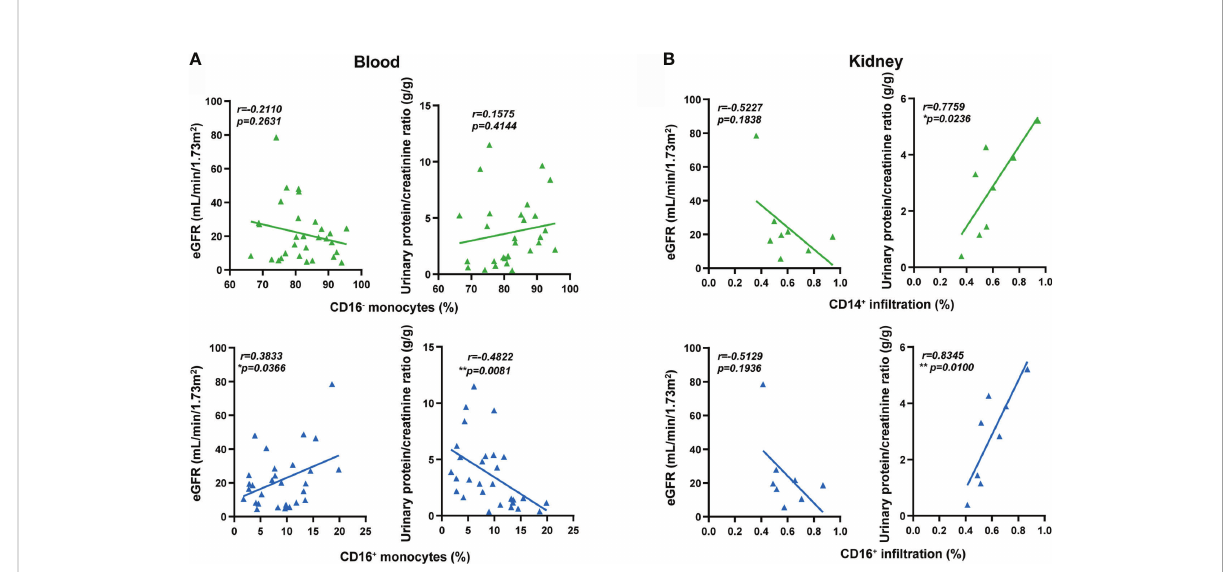
FIGURE 5 Extravasation of CD16 + monocytes was associated with renal damage in MPO-AAV patients. (A) The percentage of monocyte subsets (CD16 + and CD16 - monocytes) correlated with estimated glomerular fi ltration rate (eGFR, mL/min/1.73m 2 ) and urinary protein/creatinine ratio (g/g) in MPO-AAV patients (n = 30); (B) The extent of CD14 + and CD16 + cell in fi ltrates in the kidneys of MPO-AAV patients (n = 8) correlated with eGFR and urinary protein/creatinine ratio, respectively. * p <0.05; ** p